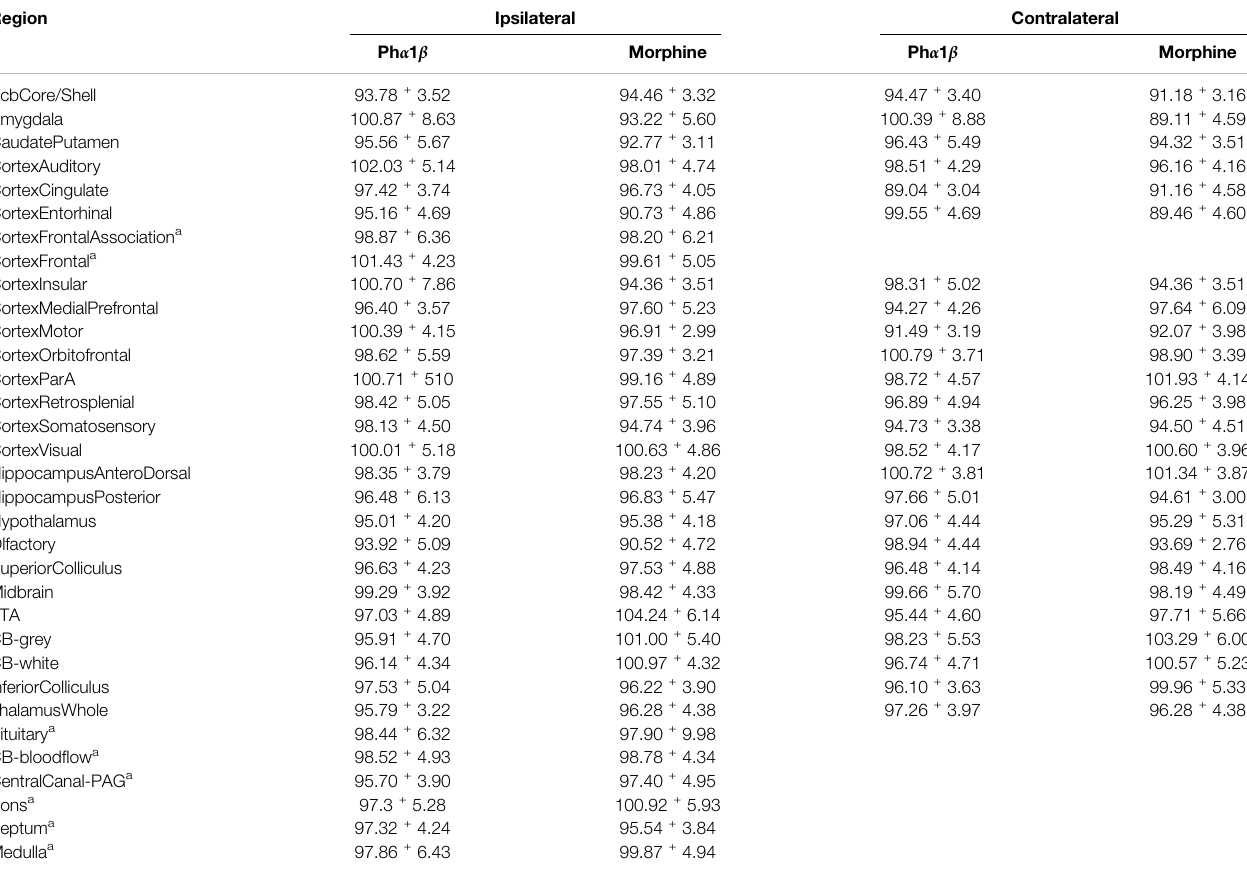
TABLE2| EffectoftreatmentwithPh α 1 β orMorphineonformalin-inducedbrainactivation:comparisonbetweenbrainregionsaccordingtothecerebralhemisphere.Values represent mean ± S. E. M. of 18 F-FDG uptake normalised by uptake in the intrathecal PBS group. Region